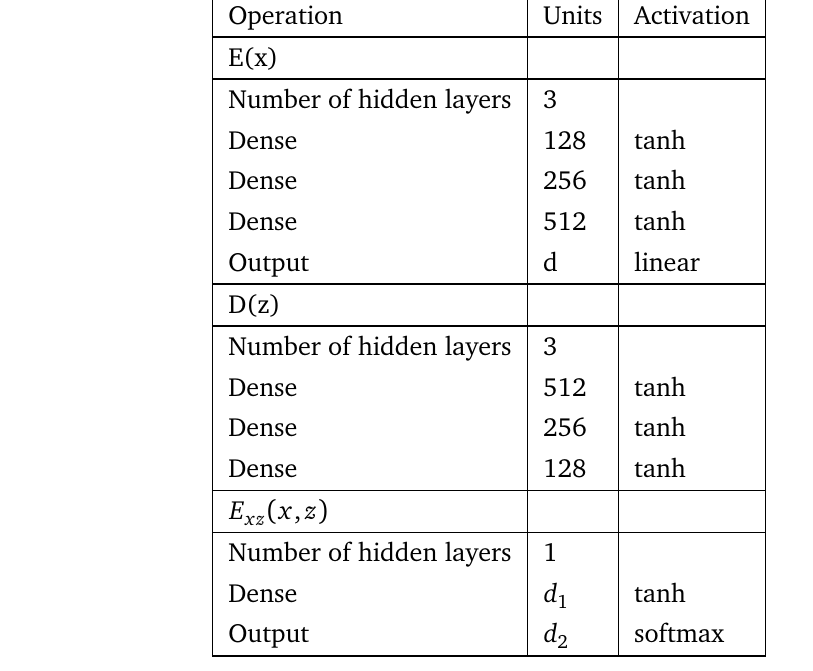
Table 18: DAGMM model architecture. Here d is the number of dimensions of the latent space whereas d and d are the number of nodes corresponding to the esti- 1 2 mation network